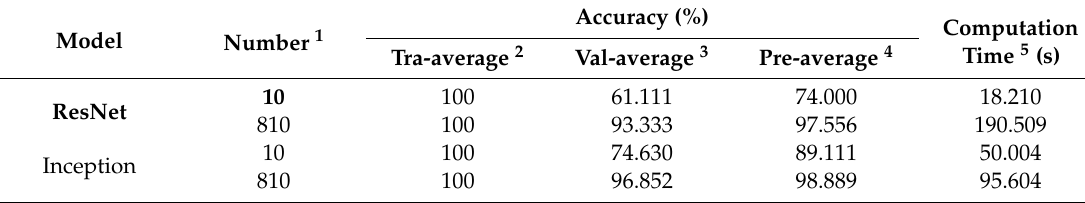
Table 3. Object-wise ResNet and Inception models used to predict average